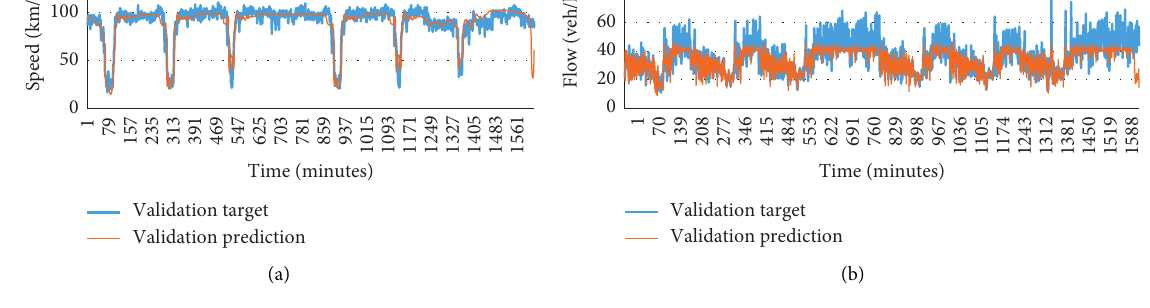
Figure 15: Speed and flow validation results for 45 minutes.